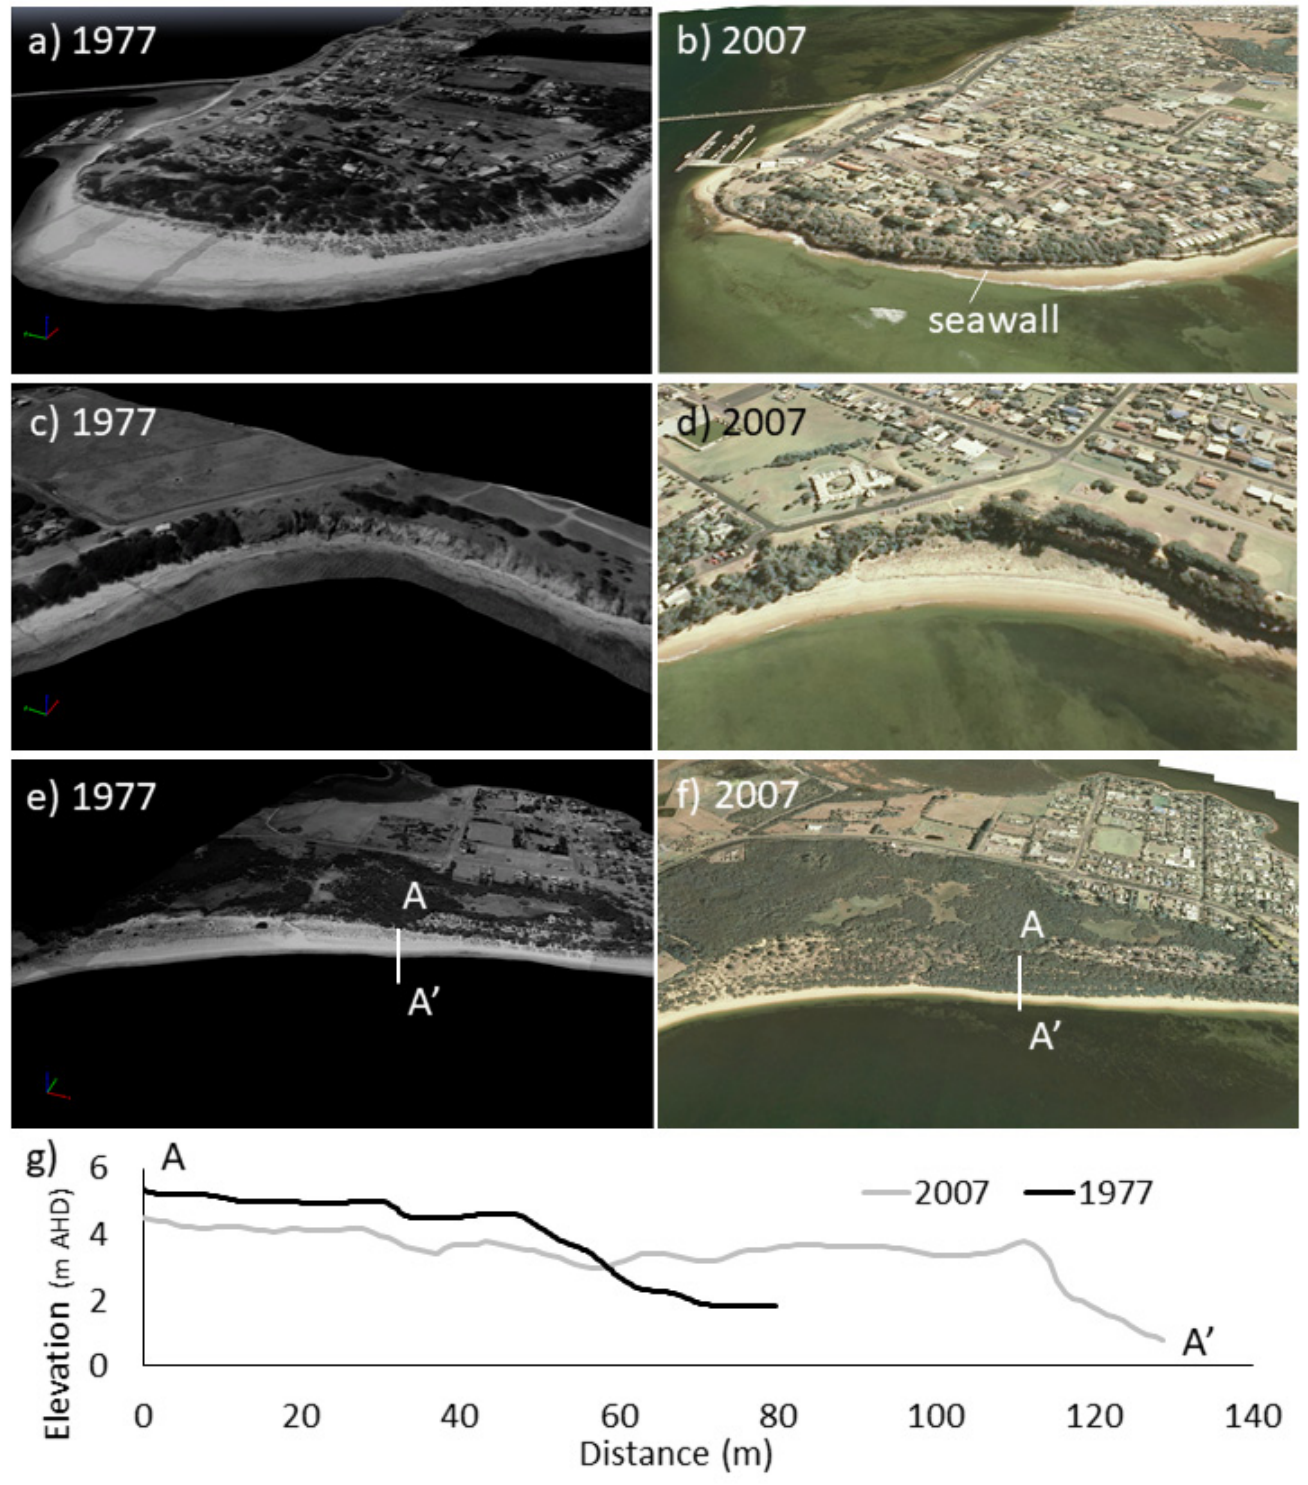
Figure 6. Oblique views in 1977 ( left ) and 2007 ( right ) at San Remo Beach ( a , b ), Back Beach ( c , d ) and Newhaven Beach ( e , f ) showing the eroding vs. depositional contrasting behaviour experienced along the shoreline on the eastern side of the channel, and the accretion experienced on the western side. Elevation profiles over time extracted from a section of the Newhaven Beach shows approximately 50 m of progradation since 1977 ( g